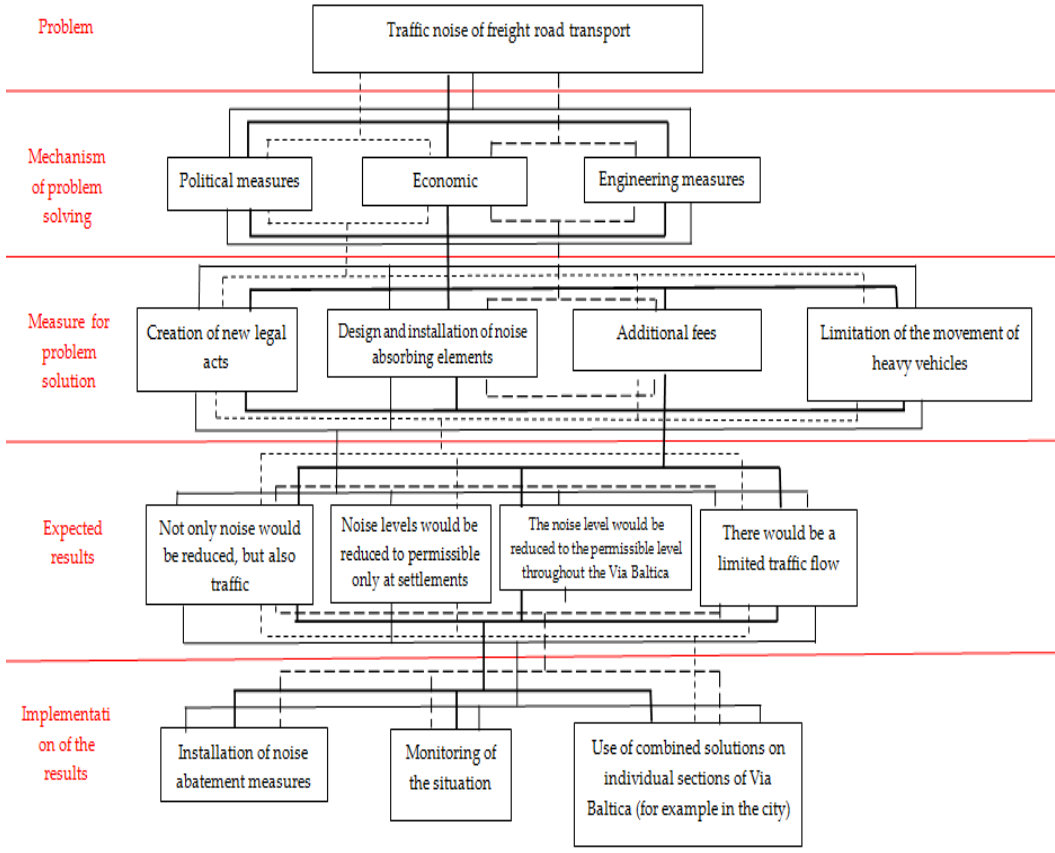
Figure 5. Mechanism of noise level reduction in international corridors.